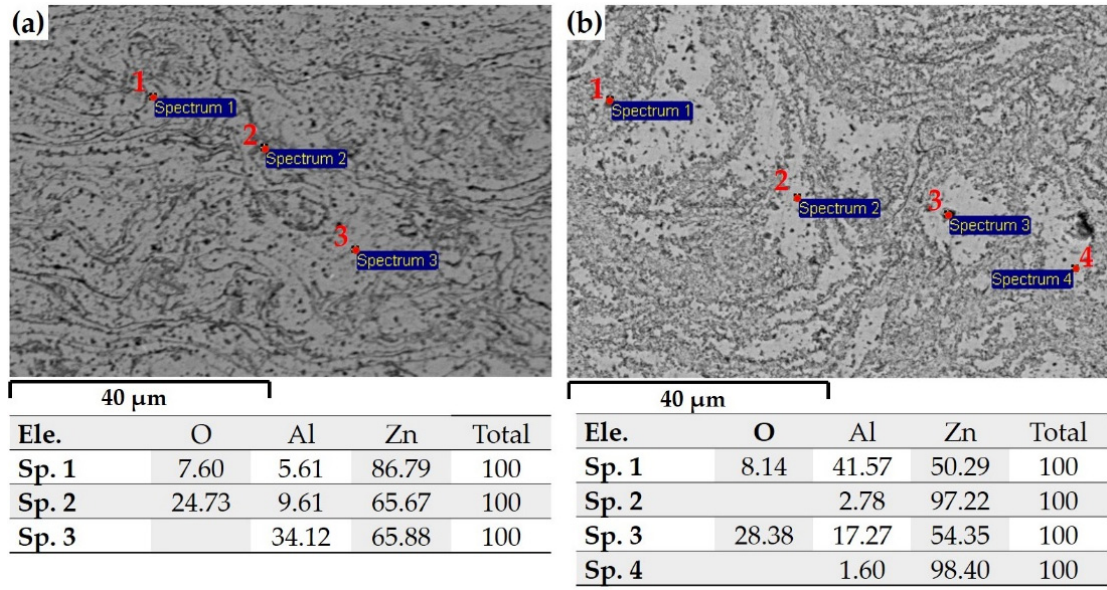
Figure 6. EDX spot analyses of the coating microstructure; ( a ) compressed air sprayed coating and ( b ) argon sprayed coating.